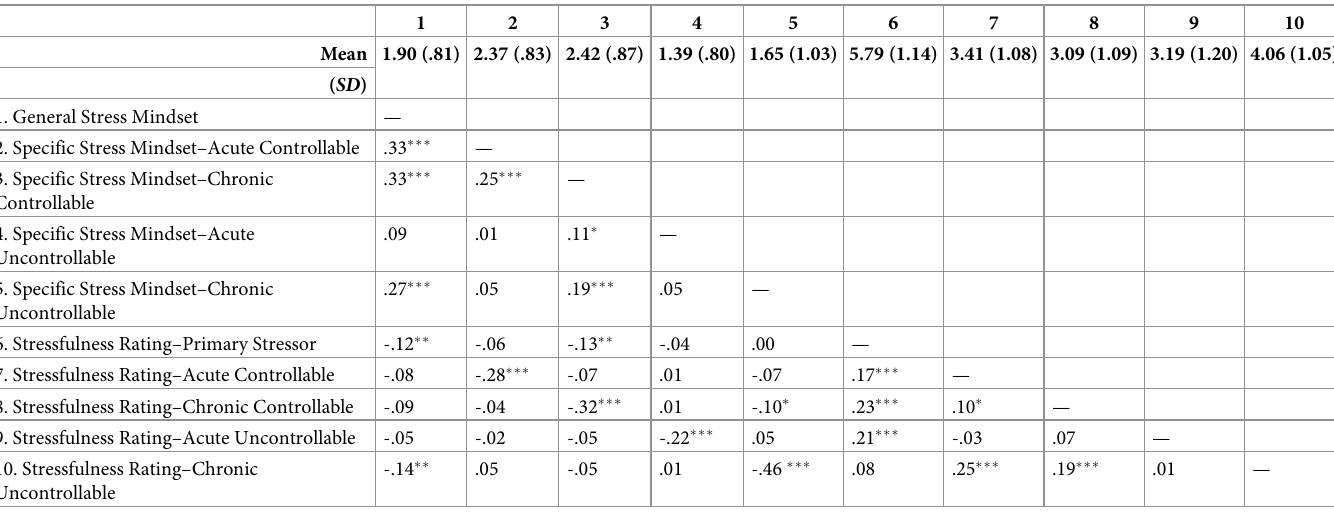
Table 3. Correlations among stress mindsets and stressfulness